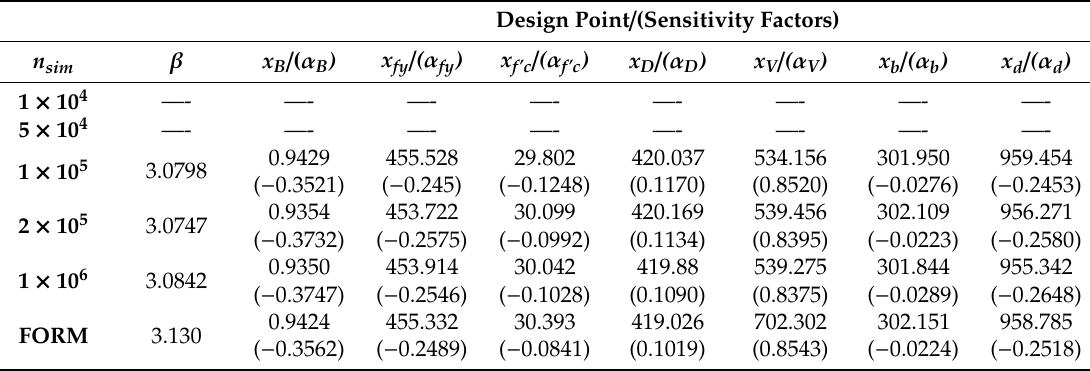
Table 4. Design point, β and α i by using multi-linear regression and FORM for the RCB. Design Point / (Sensitivity